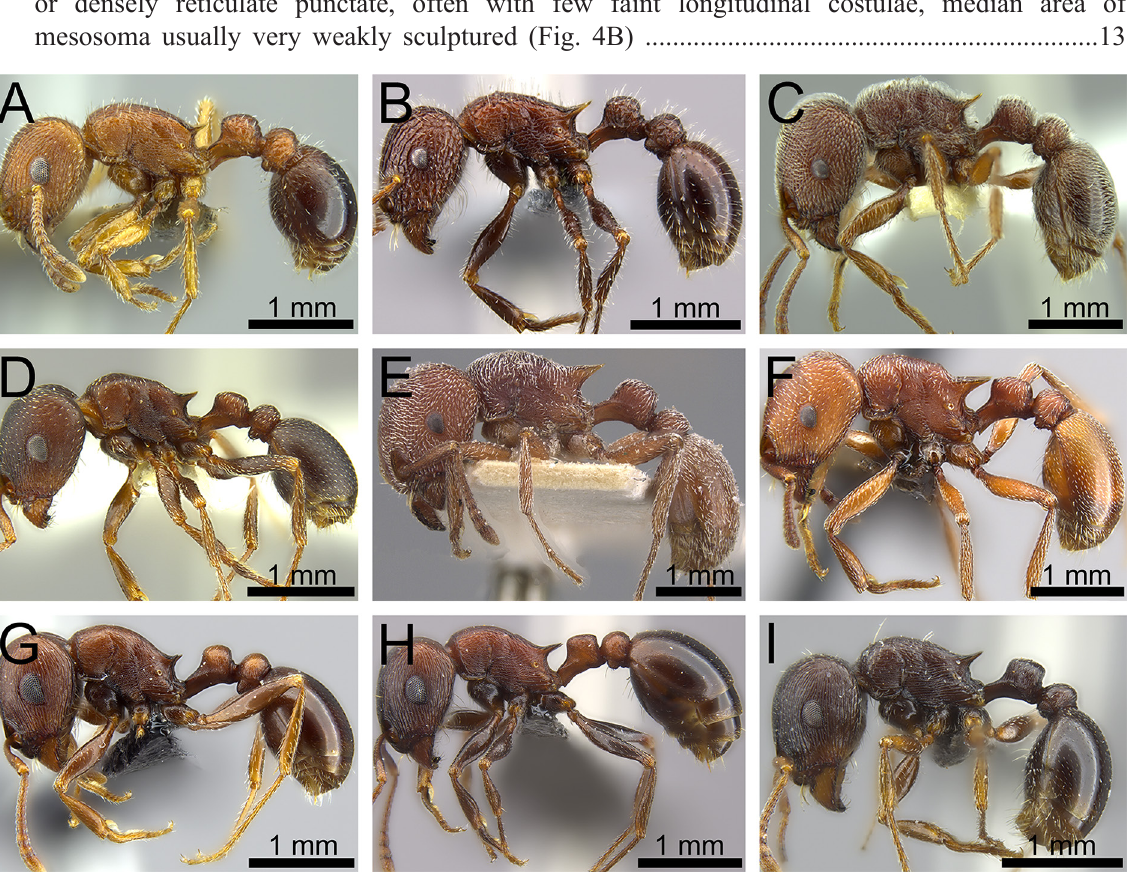
Fig. 2. Body in profile showing pilosity and pubescence. A . T. dichroum Santschi, 1932 (CASENT0746320). B . T. peringueyi Arnold, 1926 (CASENT0250873). C . T. rothschildi (Forel, 1907) (CASENT0764434). D . T. clunum Forel, 1913 (CASENT0764600). E . T. galoanasum Santschi, 1910 (CASENT0915015 – Antweb, William Ericson). F . T. setuliferum Emery, 1895